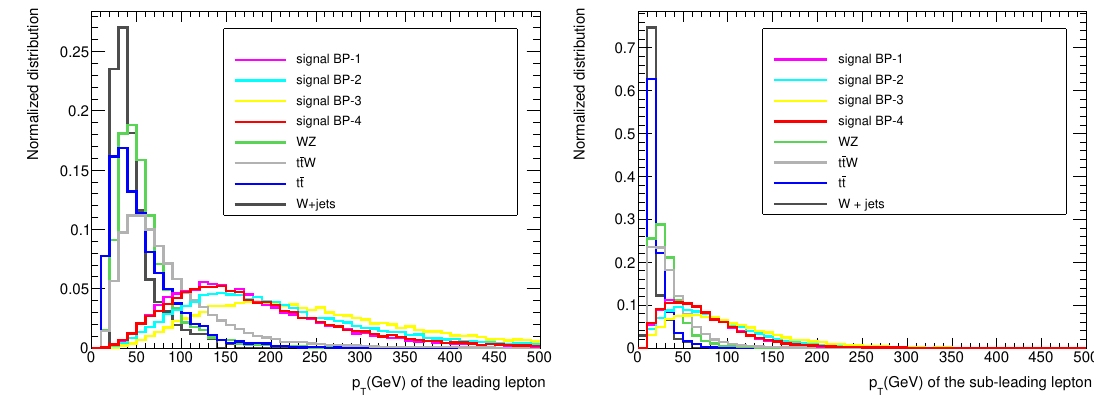
Figure 15 . Distribution of transverse momenta of the leading(left) and sub-leading(right) leptons for the four signal BPs and backgrounds in case II.